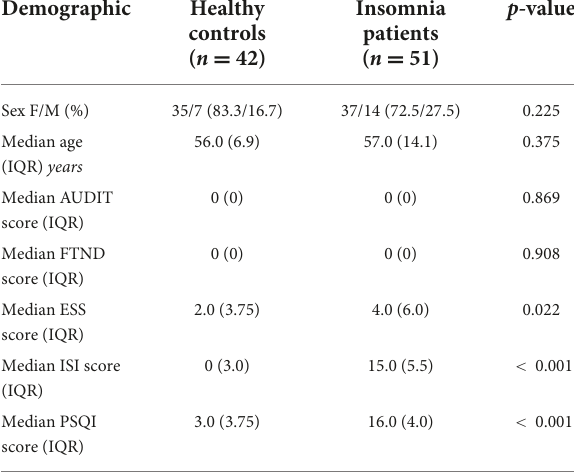
TABLE 1 Baseline characteristics for the entire cohort.